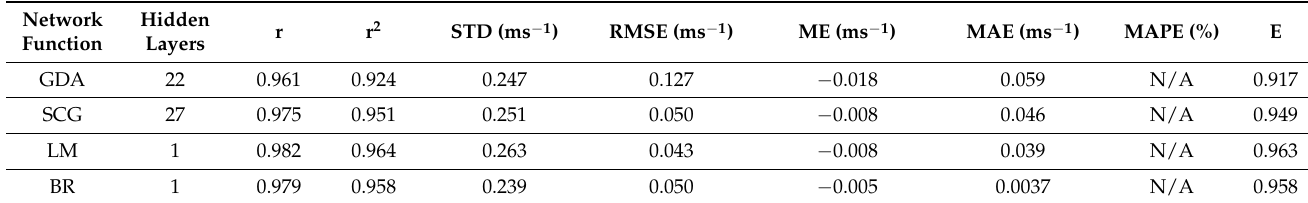
Table 2. Best-performing network for north component with statistics. MAPE = N/A due to zeros in data, rounded to three decimal